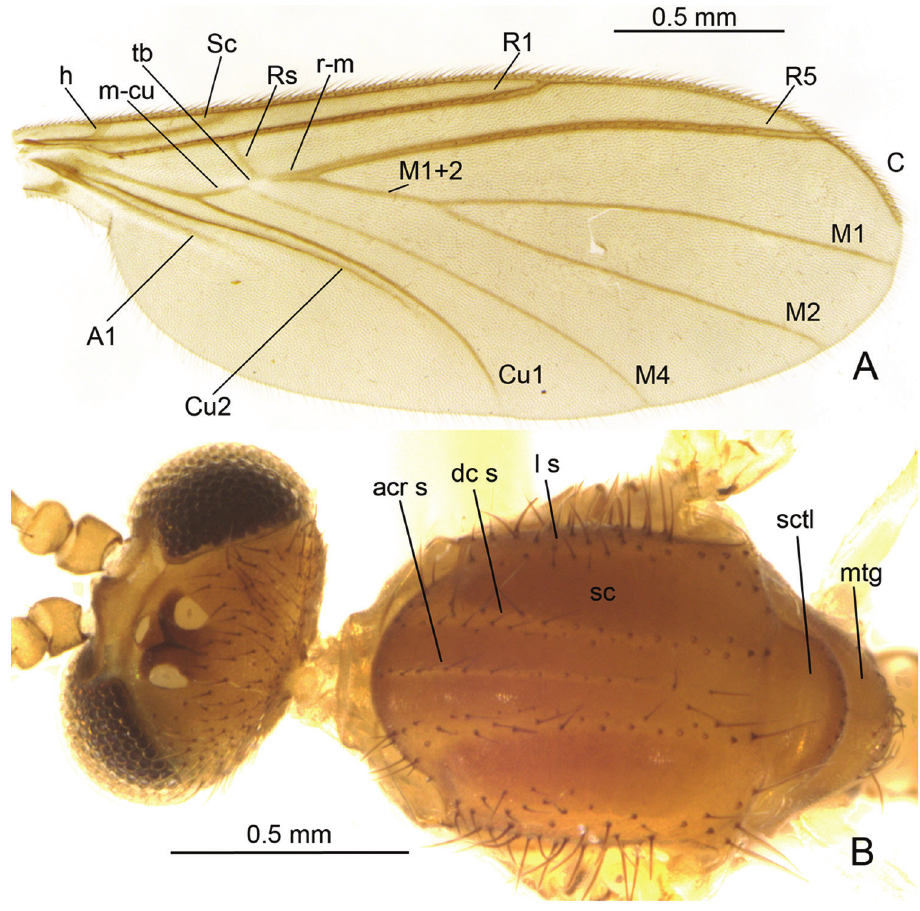
Figure 5. Kibaleana apicospinosa sp. n., male. A Wing, dorsal view B Head and thorax, dorsal view. Abbreviations: A = anal vein; acr s = acrostichal setae; C = costal vein; Cu = branches of cubitus; dc s = dor- socentral setae; h = humeral vein; l s = lateral setae; M = branches of media; m-cu = medio-cibital crossvein; mtg = mediotergite; R = branches of radius; r-m = radio-medial crossvein; Sc = subcostal vein; sc = scutum; sctl = scutellum; tb = basal